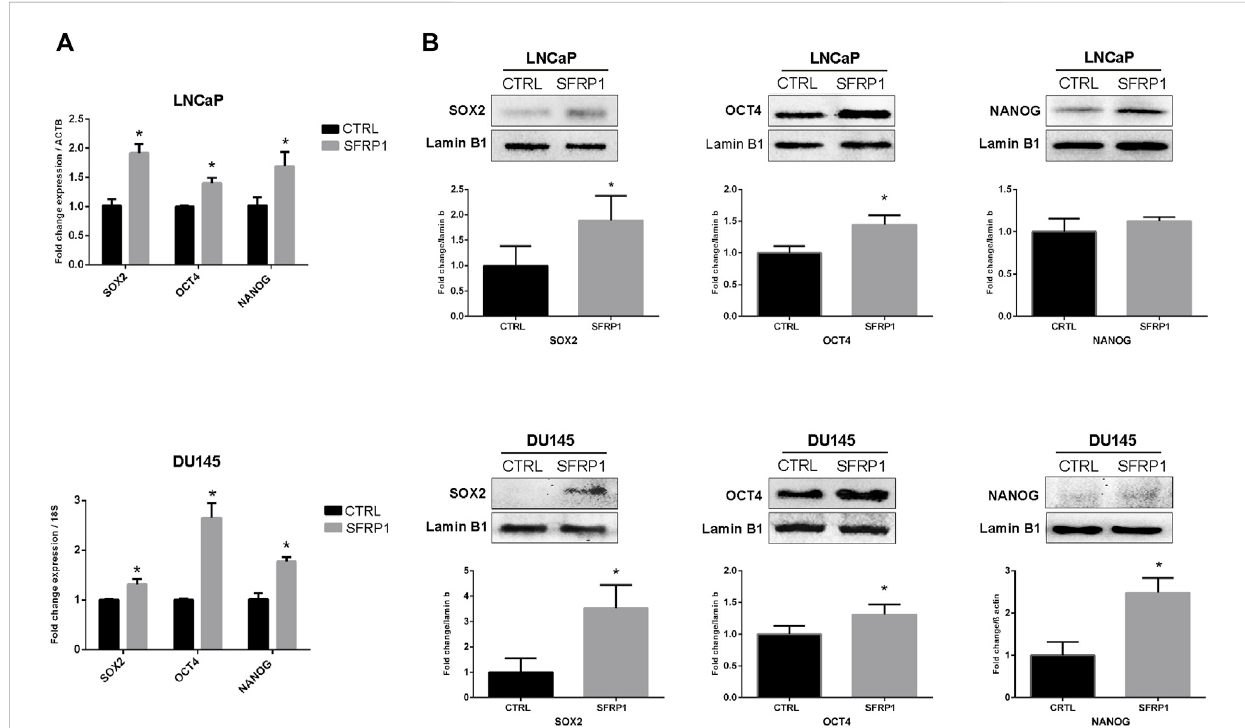
FIGURE 2 (A) LNCaPandDU145cellswereincubatedfor48 hwithSFRP1orvehicle.ExpressionlevelsofSOX2,OCT4,andNANOGweredeterminedbyqPCR. Data shows relativemRNAexpression; ß -actin(LNCaP) and 18S(DU145) wereused ashousekeeping gene (* p < 0.05). (B) Protein levels weredetermined by Western blot, lamin b1 was used as loading control, (* p <